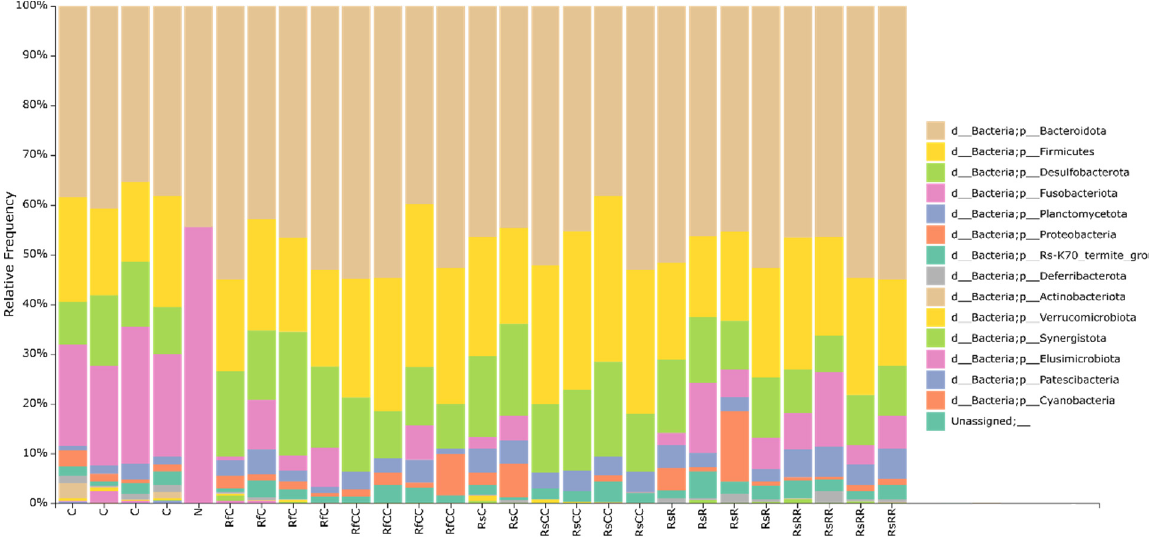
Figure 4. Bacterial composition of the B. germanica gut microbiota per sample at the phylum level. The most abundant taxa (>0.5%) are presented. The y-axis represents the proportion of sequencing reads belonging to each taxon. N, negative control (water).